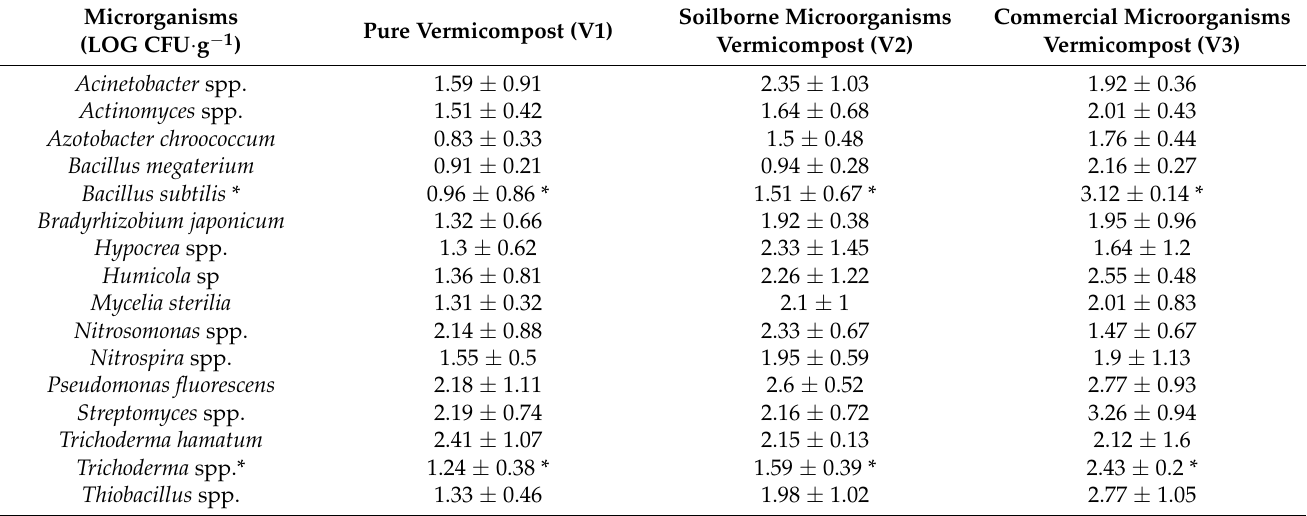
Table 5. Identification and quantification of microorganisms were evaluated in each treatment with three replicates (mean ± standard